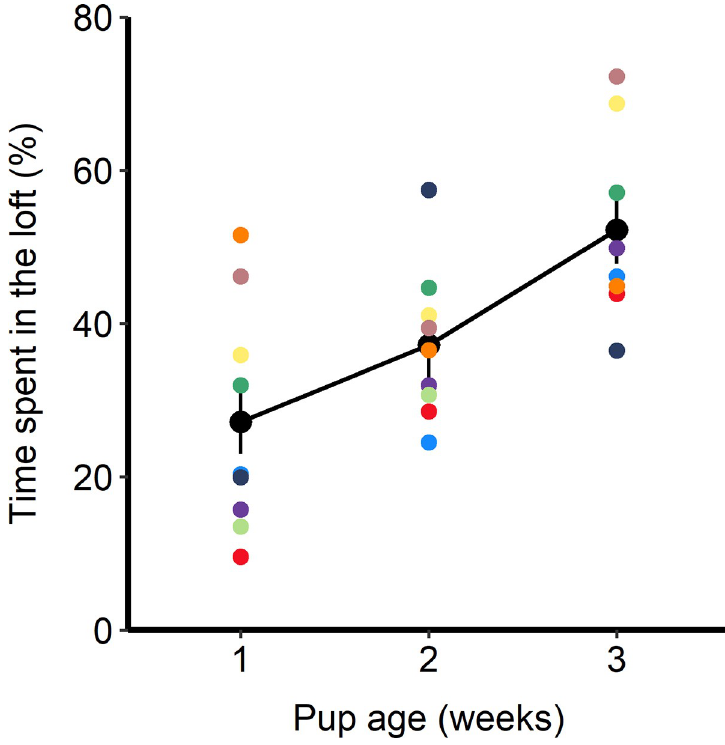
Fig 2. Mean time spent in the loft per week, expressed as a percentage of observational scans, for rats with loft access. The large black points and vertical bars depict least-square (LS) means and standard errors from the model output; smaller colorful points show the means of individual rats (n = 9